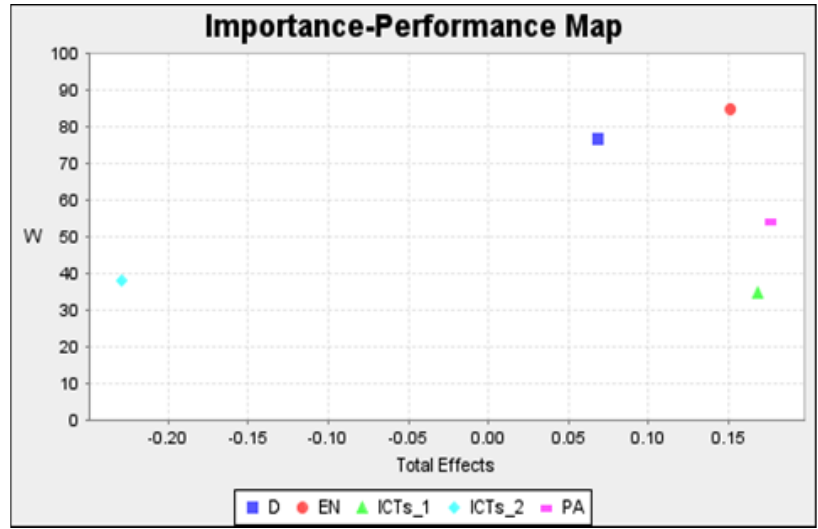
Figure 2. Importance-performance map of constructs to weight. D: Dietary factors; EN: Environ- ment; ICTs_1: Sedentary information and communication technologies; ICTs_2: Information and communication technology not associated with physical inactivity; PA: Physical activity; W: Weight.